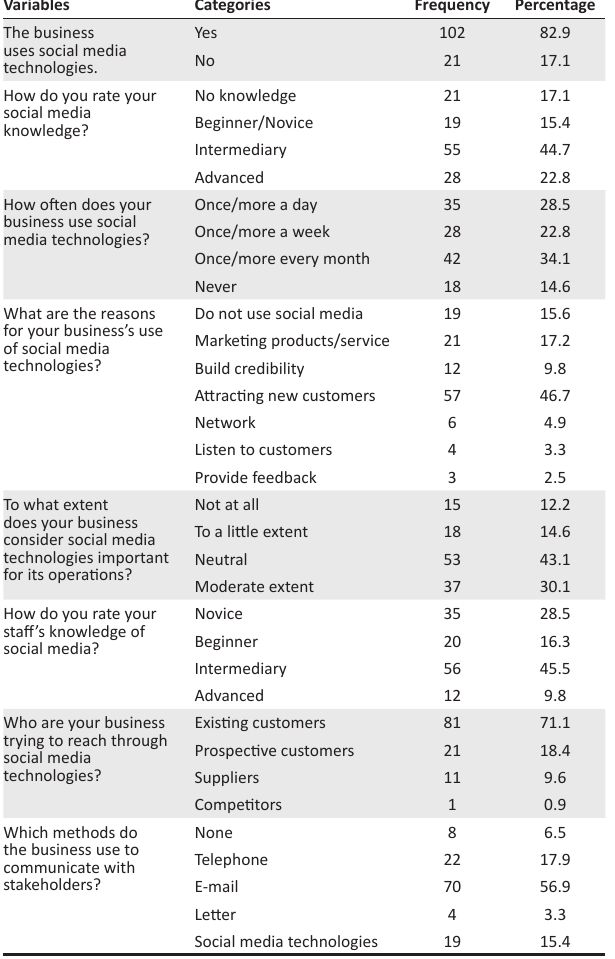
TABLE 3: Status and utilisation of social media technologies.